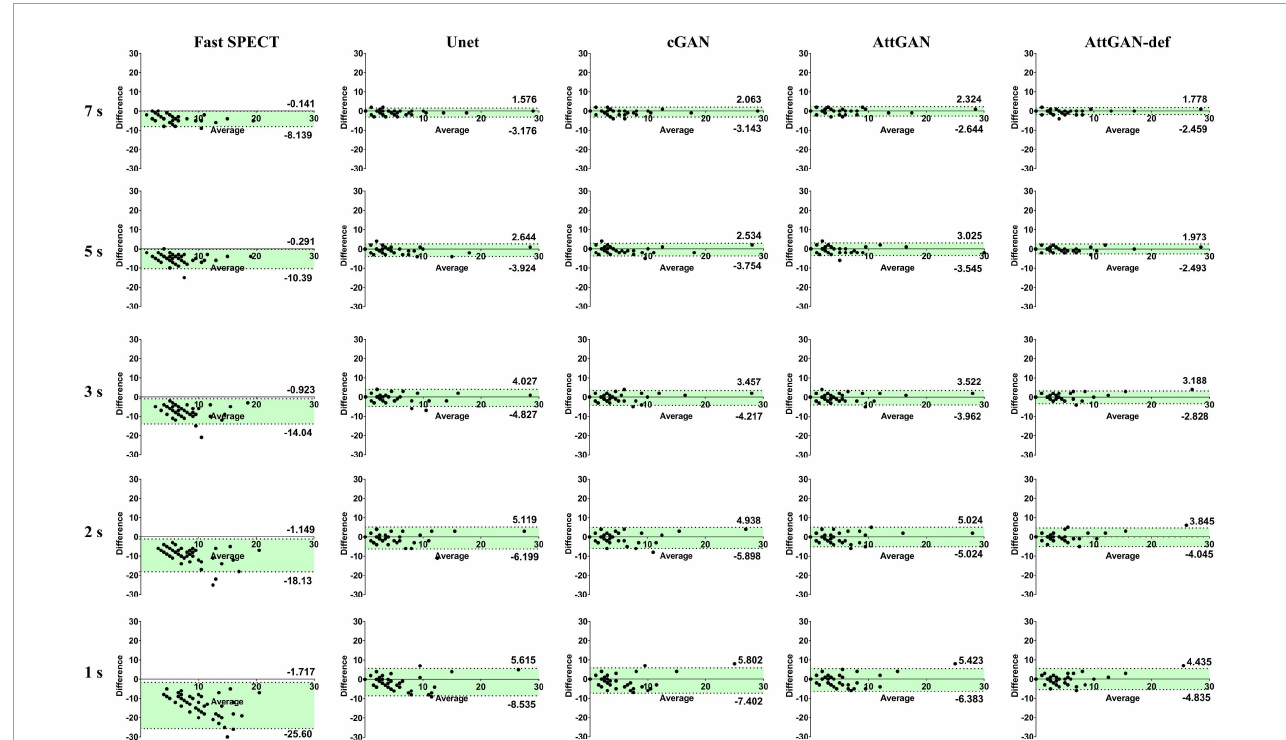
FIGURE7 The Bland-Altman plots of PDS for fast SPECT different denoised images and acquisition times. The filtered FT SPECT images are used as reference.